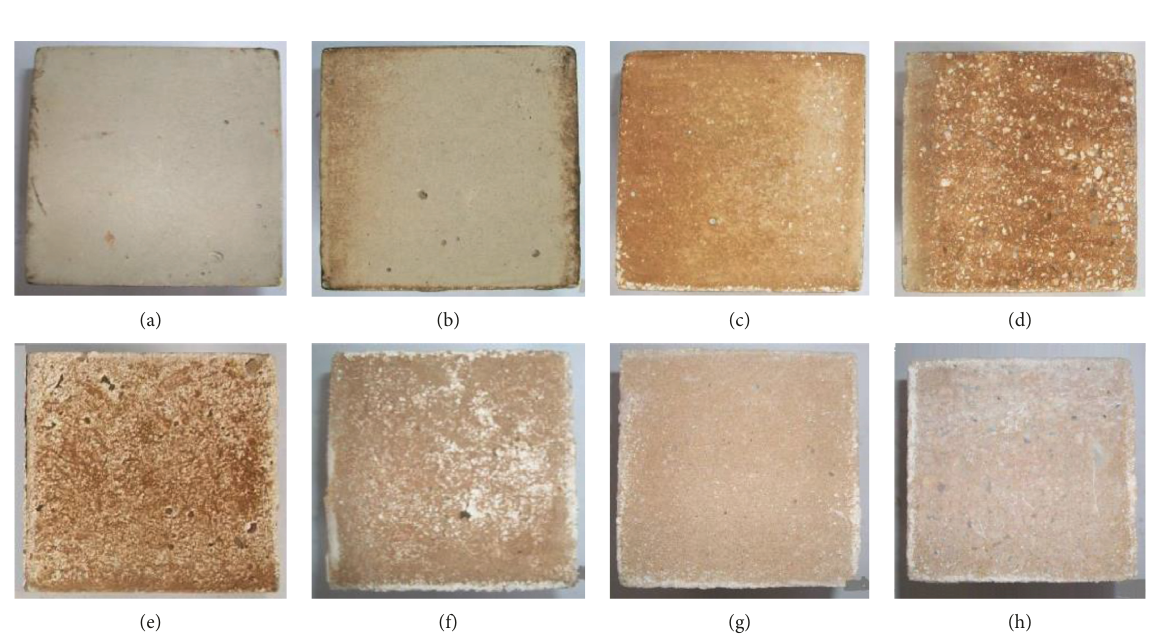
Figure 3: Apparent characteristics of concrete subjected to sulfuric acid corrosion after 150 days. (a) pH w / c 0.50. (c) pH (cid:30) (h) pH 2.00, w / c (cid:30)